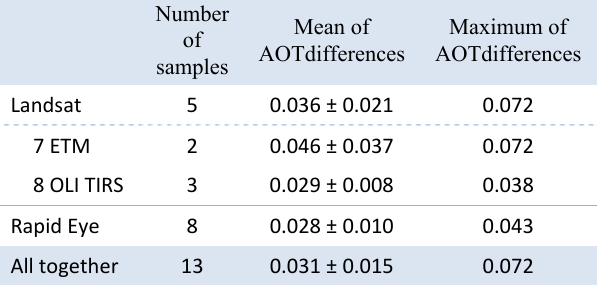
Table 2. AOT retrieval uncertainty (NxN area mean) for cloudless images of the regional data set.